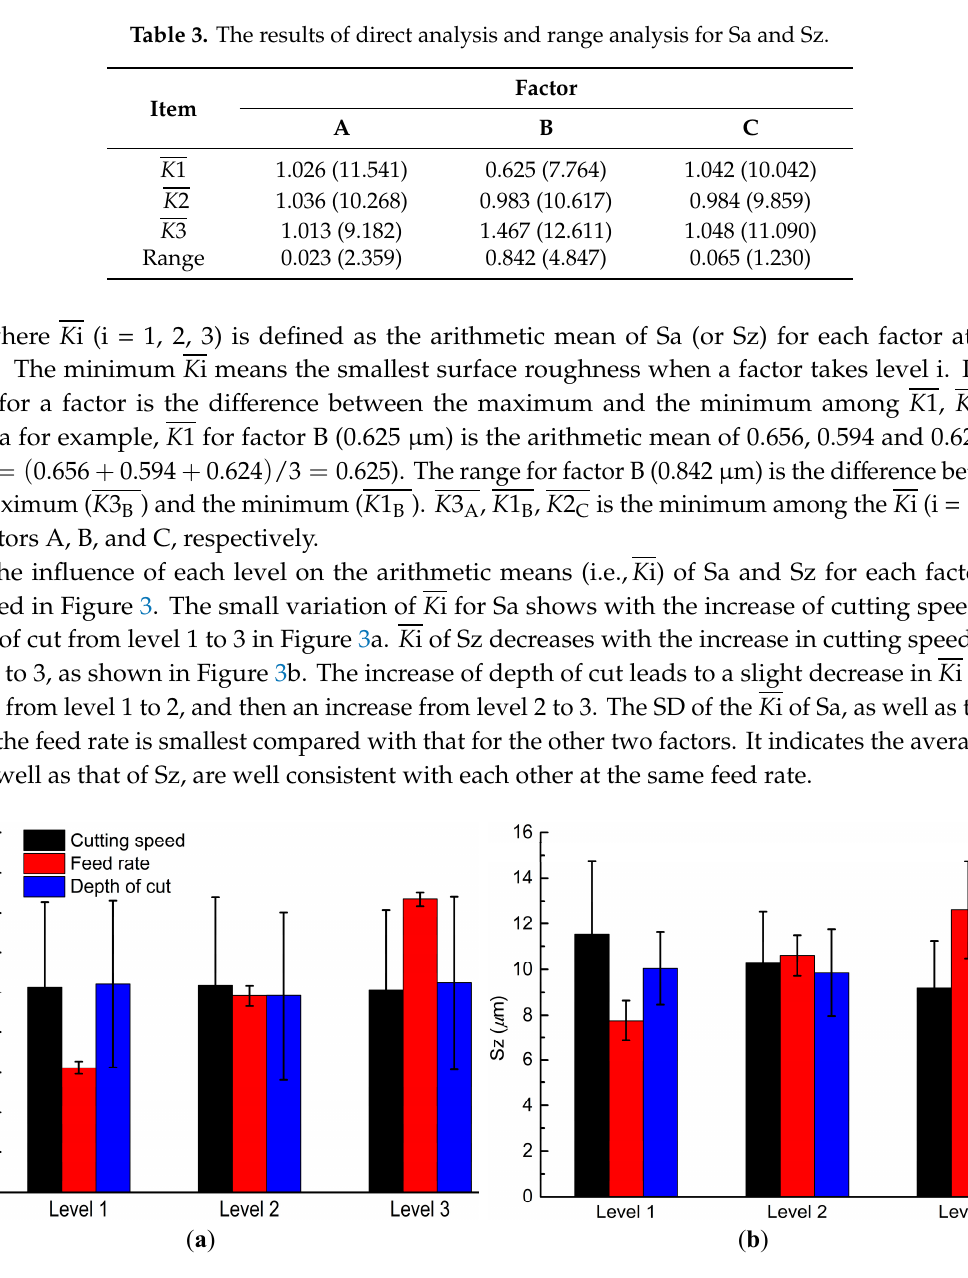
Figure 3. The influence of each level on the arithmetic mean of Sa ( a ) and Sz ( b ) for each